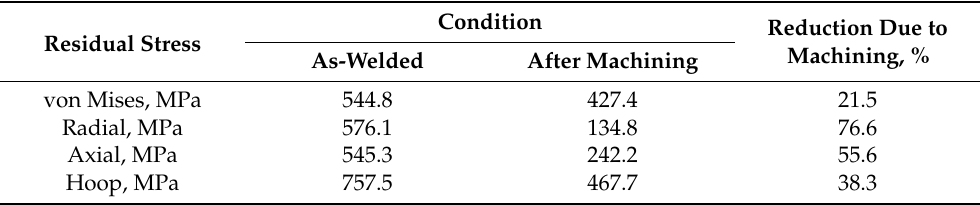
Table 16. Reduction of maximum weld residual stresses due to